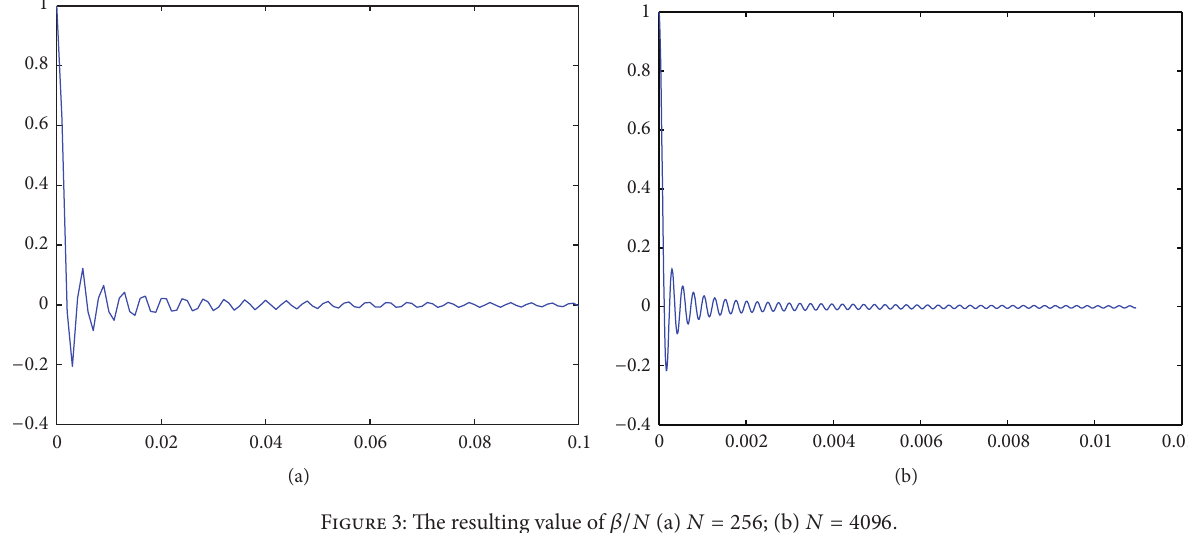
Figure 3: The resulting value of 𝛽/𝑁 (a) 𝑁 = 256 ; (b) 𝑁 = 4096 .